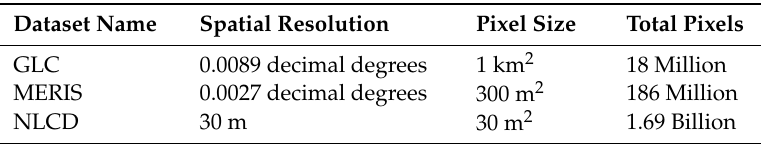
Table 1. Raster dataset description.